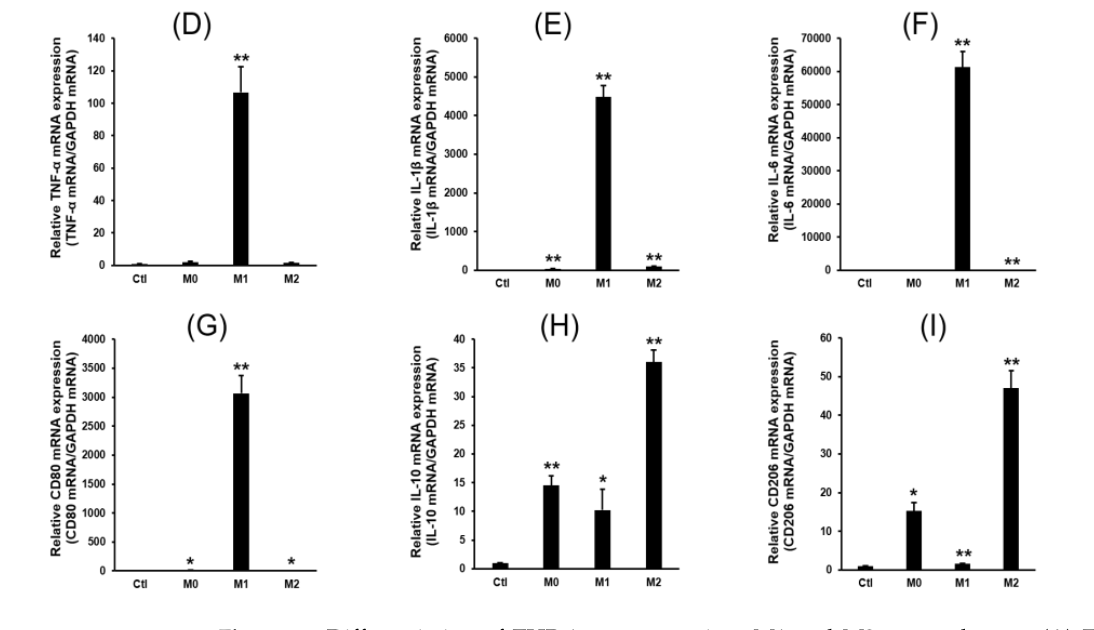
Figure 1. Differentiation of THP-1 monocytes into M1 and M2 macrophages. ( A ) THP-1 cells were induced to form M0 macrophages with the treatment of PMA (200 ng/mL) for 24 h. ( B ) M0 macrophages were polarized into M1 macrophages using 100 ng/mL of LPS and 20 ng/mL of recombinant human IFN-γ. The sharpened shapes of M1 macrophages are indicated by arrow. ( C ) M0 macrophages were polarized into M2 macrophages using 20 ng/mL of recombinant human IL-4 and 20 ng/mL of IL-13. The flattened shapes of M2 macrophages are indicated by arrow. Quantitative real time PCR analysis of M1 and M2 macrophage-specific gene expression was conducted. ( D ) TNF-α mRNA expression, ( E ) IL-1β mRNA expression, ( F ) IL-6 mRNA expression, ( G ) CD80 mRNA ex- pression, ( H ) IL-10 mRNA expression, and ( I ) CD206 mRNA expression. Details of the primers and